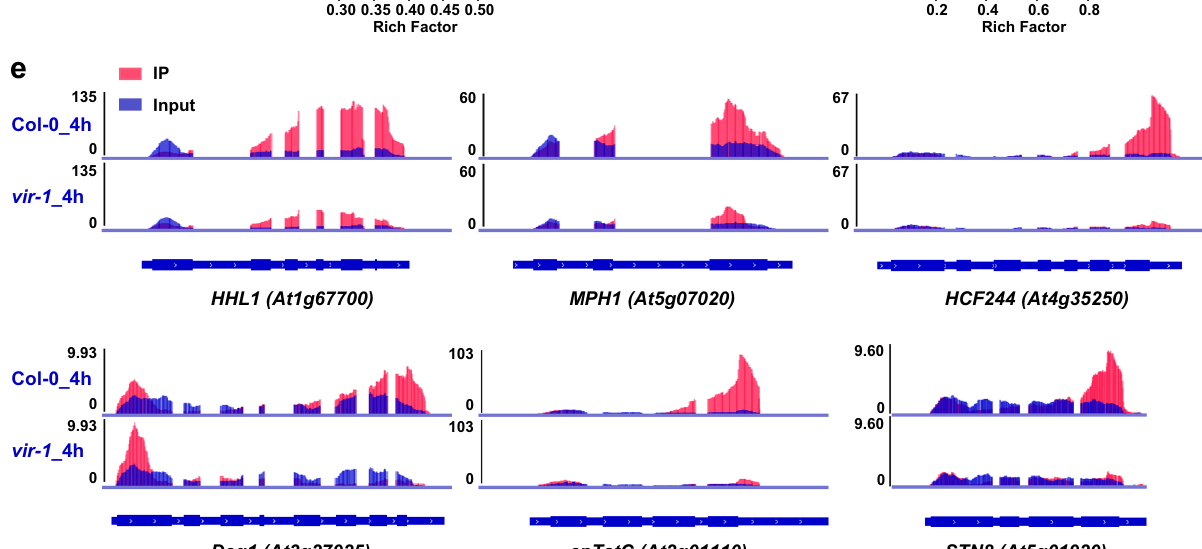
treatment.Statisticaltestwasdeterminedbyone-sided hypergeometrictest. d GO analysis of VIR-dependent m 6 A-containing genes after a 4-h HL treatment. Statis- ticaltestwasdeterminedbyone-sidedhypergeometrictest. e LossofVIRfunction results in lower (or loss of) m 6 A peaks compared to Col-0 seedlings after a 4-h HL. Blue,inputreads;red,IPreads.Thegenemodelsareshownbelow,withthickboxes and lines representing exons and introns,